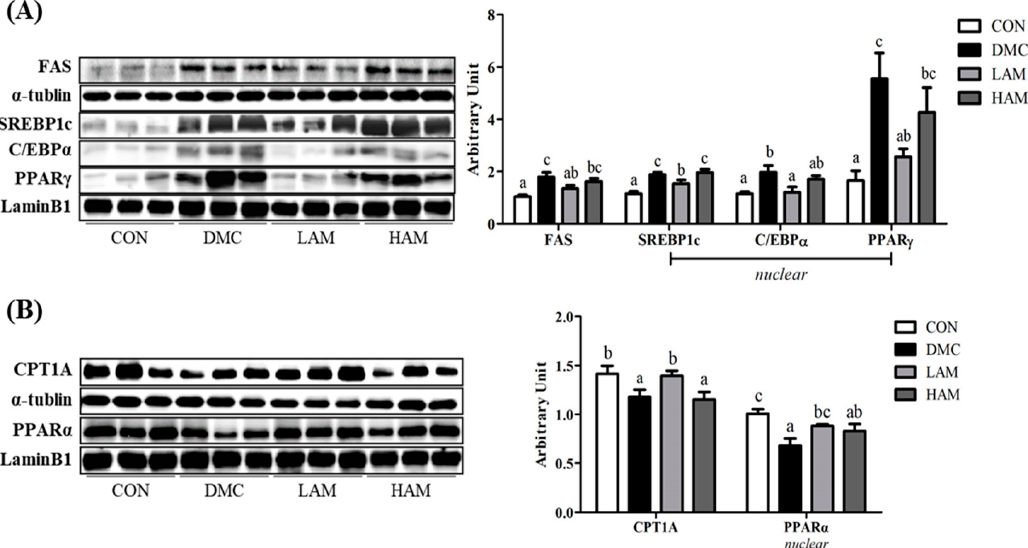
Figure 10. Effect of AME on lipid metabolism, ( A ) lipogenesis related markers ( B ) β -oxidation related markers, in T2DM mice All values are reported as mean and SEM. Values with the different superscript letter were significantly different ( p < 0.05; ANOVA with post-hoc Duncan’s multiple range test). n = 6 mice in each group CON, normal control group (negative control); DMC, type 2 diabetic control group (positive control); LAM, diabetic group supplemented with low dosage (50 mg/kg BW) of AME; HAM, diabetic group supplemented with high dosage (100 mg/kg BW) of AME.